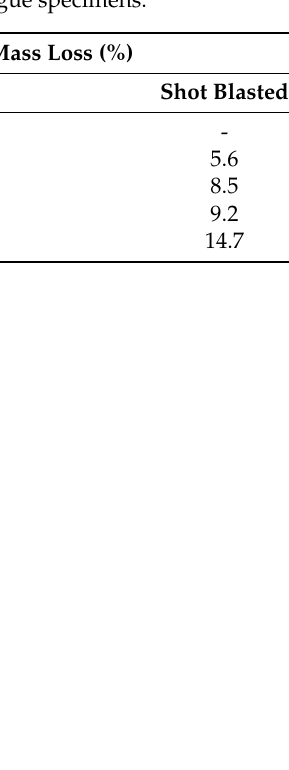
Figure 4. Mass loss vs. corrosion time for fatigue specimens.